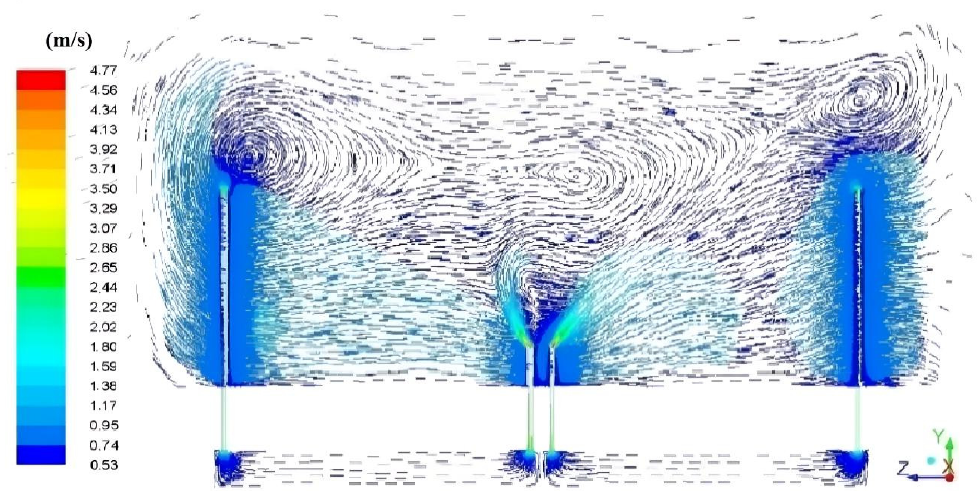
Figure 13. Pathlines of air circulation and its velocity (m/s) at the greenhouse center and the rock bed of the longitudinal plane during the